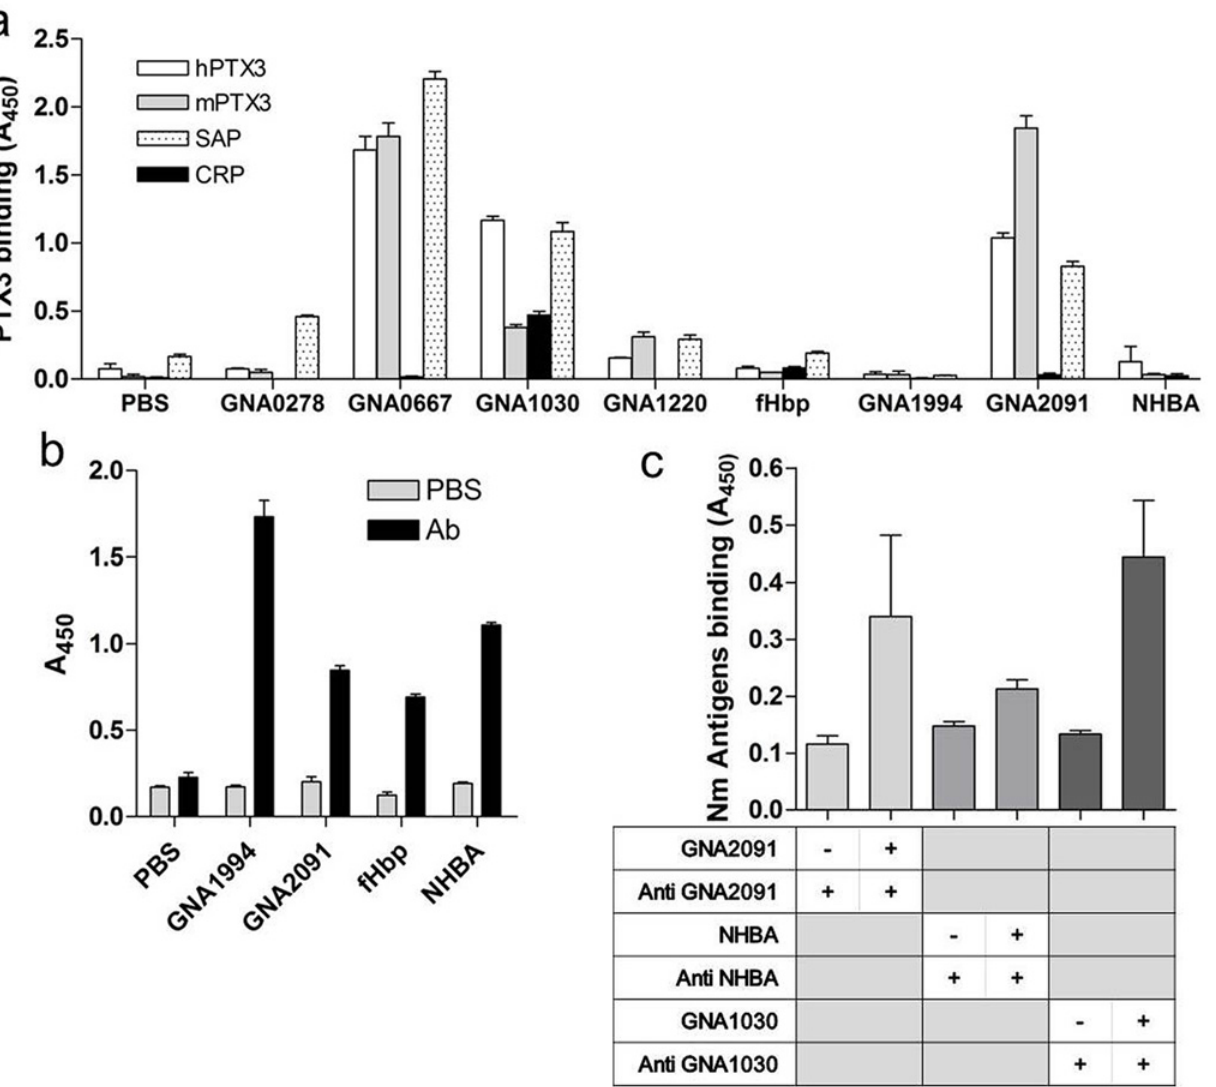
Fig 3. Interaction of PTX3 with recombinant proteins from Neisseria meningitidis . Binding was evaluated on plastic-immobilized proteins and expressed as mean A 450 ± SD from triplicate wells. a) Plastic wells were coated with the different recombinant proteins (1 μ g/well) and incubated with human or murine PTX3, human CRP and SAP (22 pmoles of all proteins) for 1 h at 37°C before addition of the different antibodies. Results are from one out of three independent experiments. b) plastic wells were coated with the indicated Nm antigens (1 μ g/well) and incubated with specific polyclonal antibodies (all diluted 1:1000) against the different Nm proteins. c) Plates were coated with recombinant PTX3 (1 μ g/well) and binding was evaluated incubating with the indicated Nm antigens (1 μ g/well) followed by incubation with specific antibodies. As background control, incubation with Neisserial antigens was omitted while wells were incubated with the specific